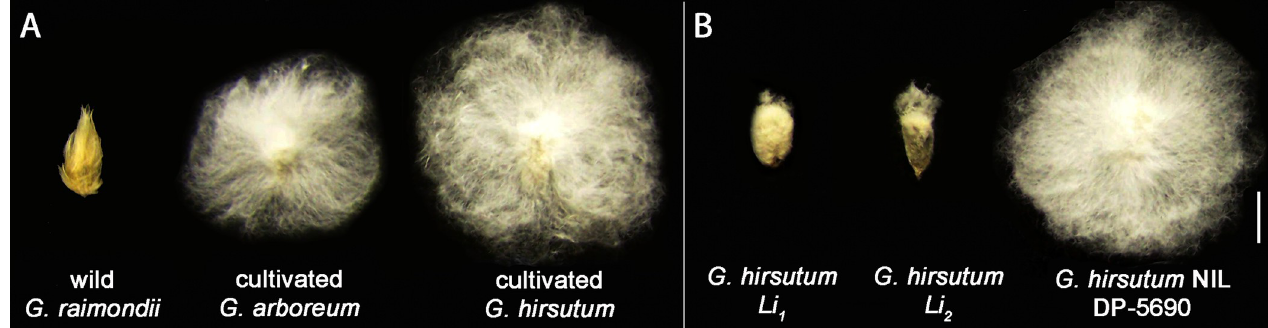
Fig 1. Morphology of two sets of cottonseeds for an integrative analysis. A. The 1 st set is composed of three cotton species including wild diploid G . raimondii D 5 -31 (D 5 genome), cultivated diploid G . arboreum A 2 -100 (A 2 genome), and cultivated polyploid G . hirsutum TM-1 (AD 1 genome). B. The 2 nd set consists of G . hirsutum Li and Li mutants producing short fibers along with their near isogenic line (NIL) DP-5690 producing long fibers. The single seeds 1 2 with associating cotton fibers were harvested from the open bolls, combed and photographed. The bars represent 1 cm in length.